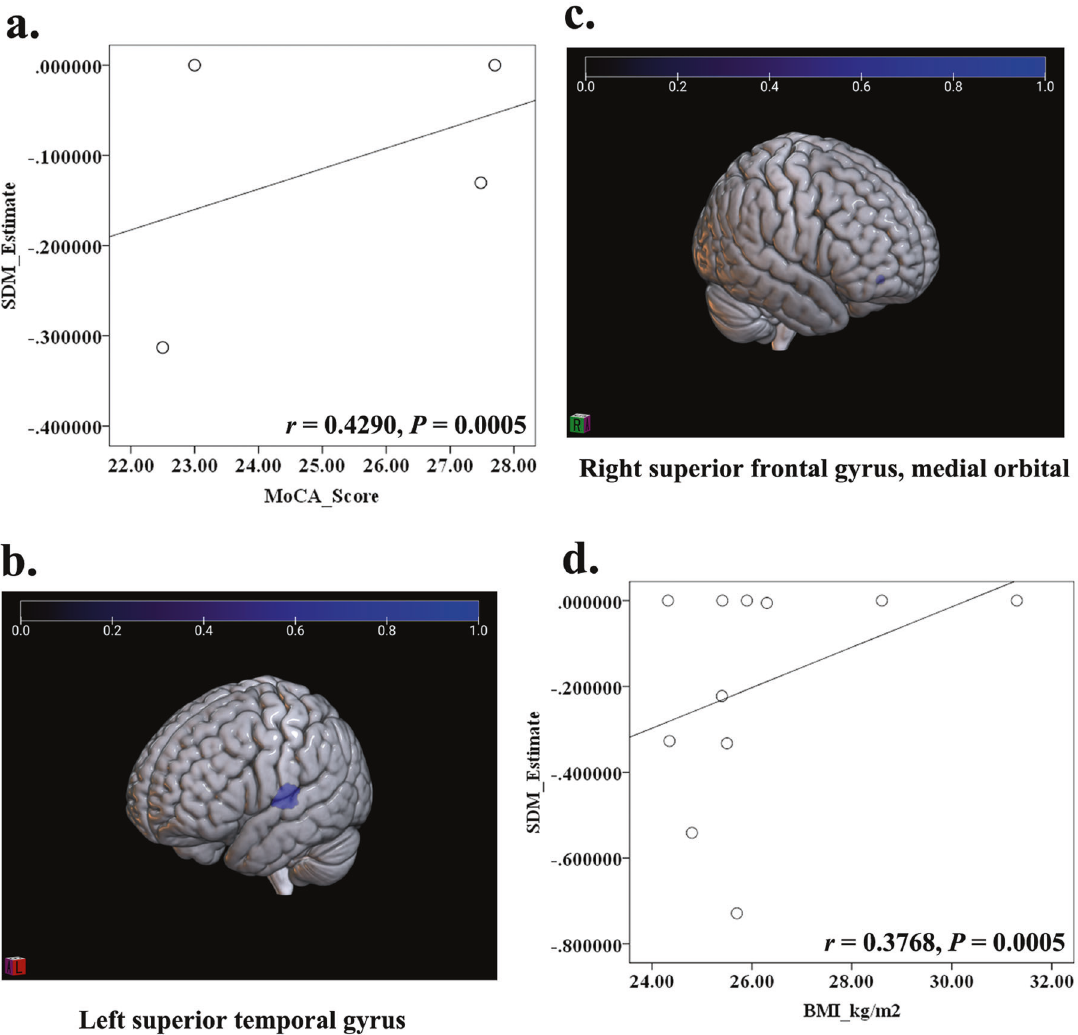
Fig. 4 The relationship between MoCA score, BMI, and decreased GM in patients with T2DM-CD. According to the meta-regression, the MoCA score was positively related with the decreased GM in PFCventmed.R ( a , c ) ( r = 0.4290, P < 0.0005), while the BMI was positively related with the decreased GM in STG.L ( b , d ) ( r = 0.3768, P <